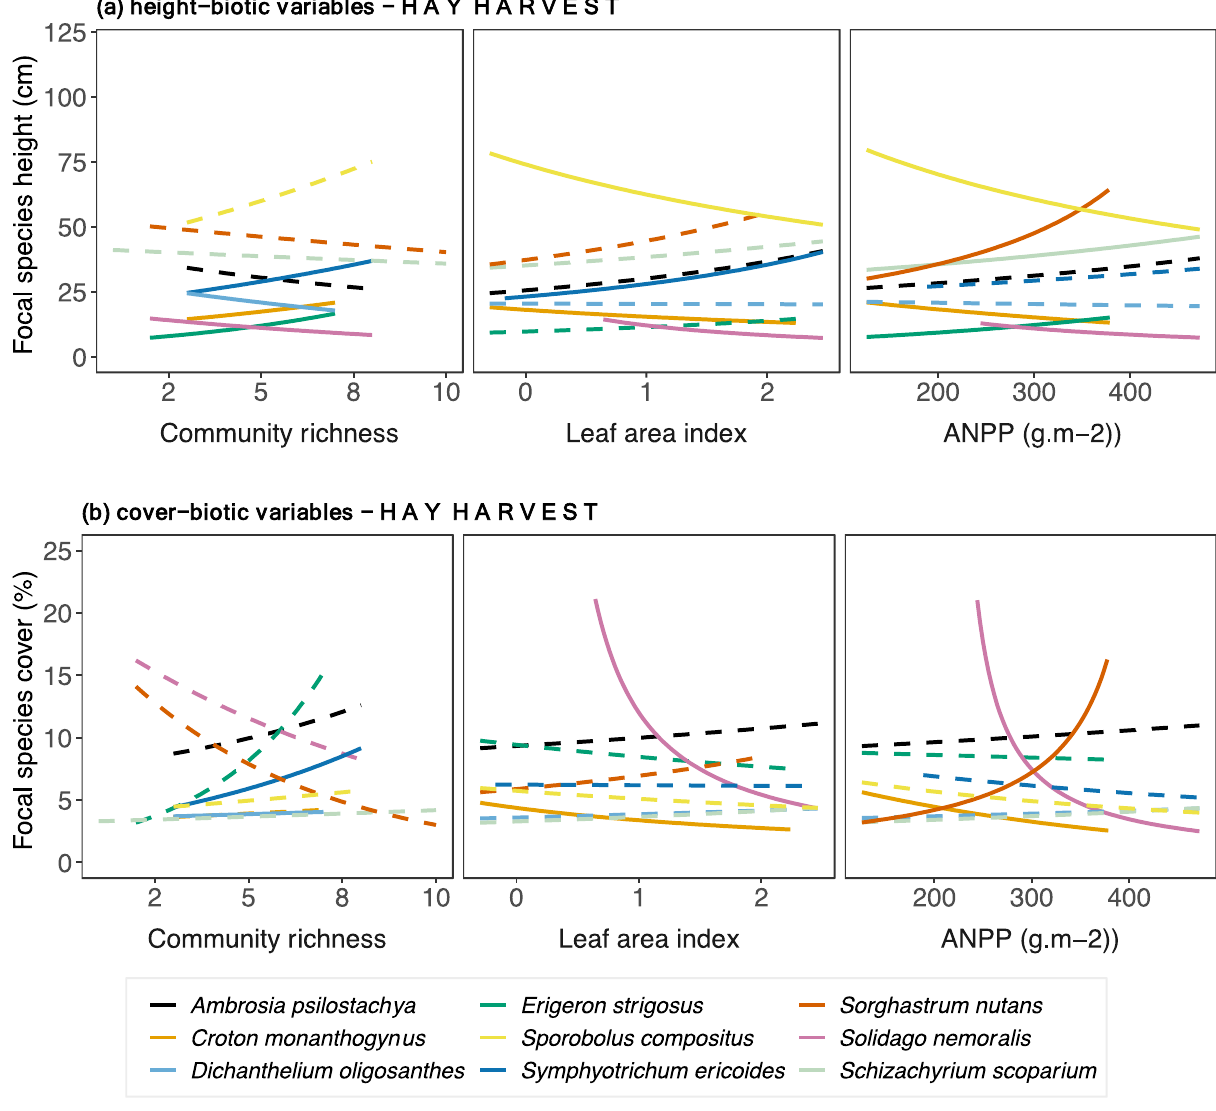
Mixed Models with log link to both species-specific height and biotic variables (community richness, leaf area index, above-ground net primary). Continuous lines indicate significant relationships, while dashed lines indicate non-significant. P -values are shown in Table